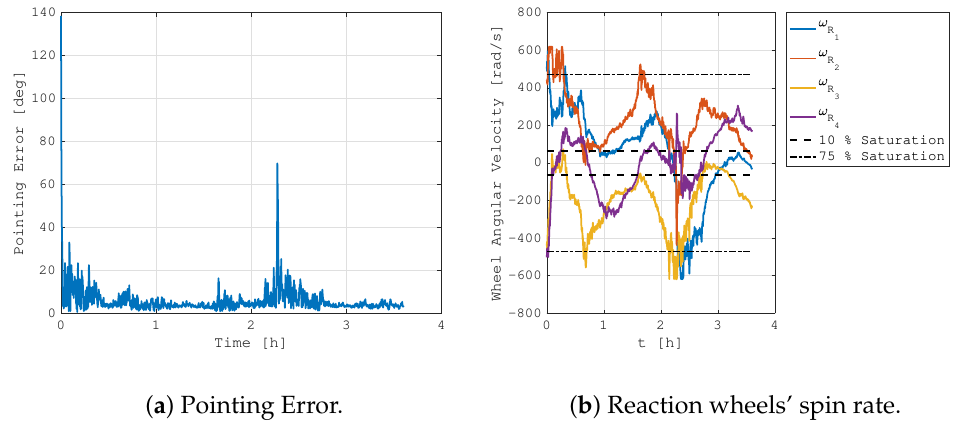
Figure 11. MIL simulation of nadir-pointing control without integrated magnetic angular momentum